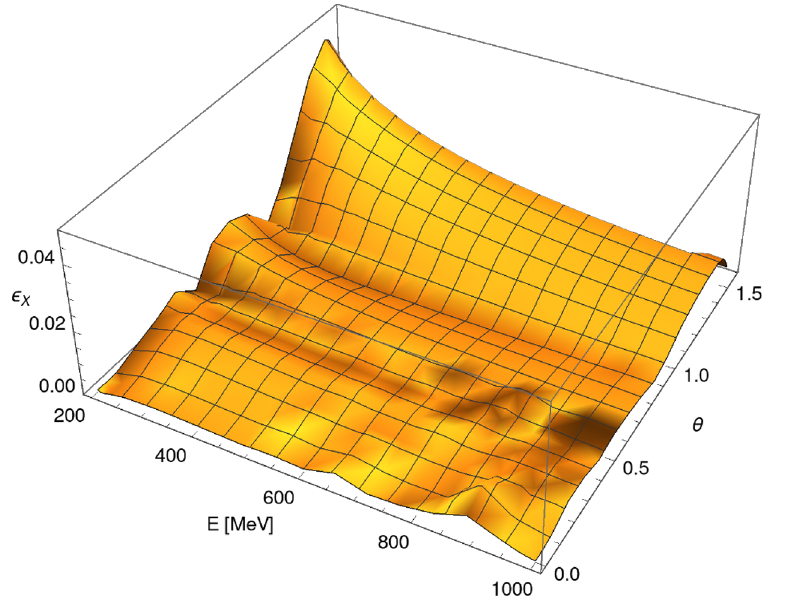
Figure 12 . Relative error " X of (cid:11) X ; (cid:30) X (cid:12)t plotted as a function of energy varied from 200 to 1000 MeV and azimuthal angle varied from 0 to (cid:25)=